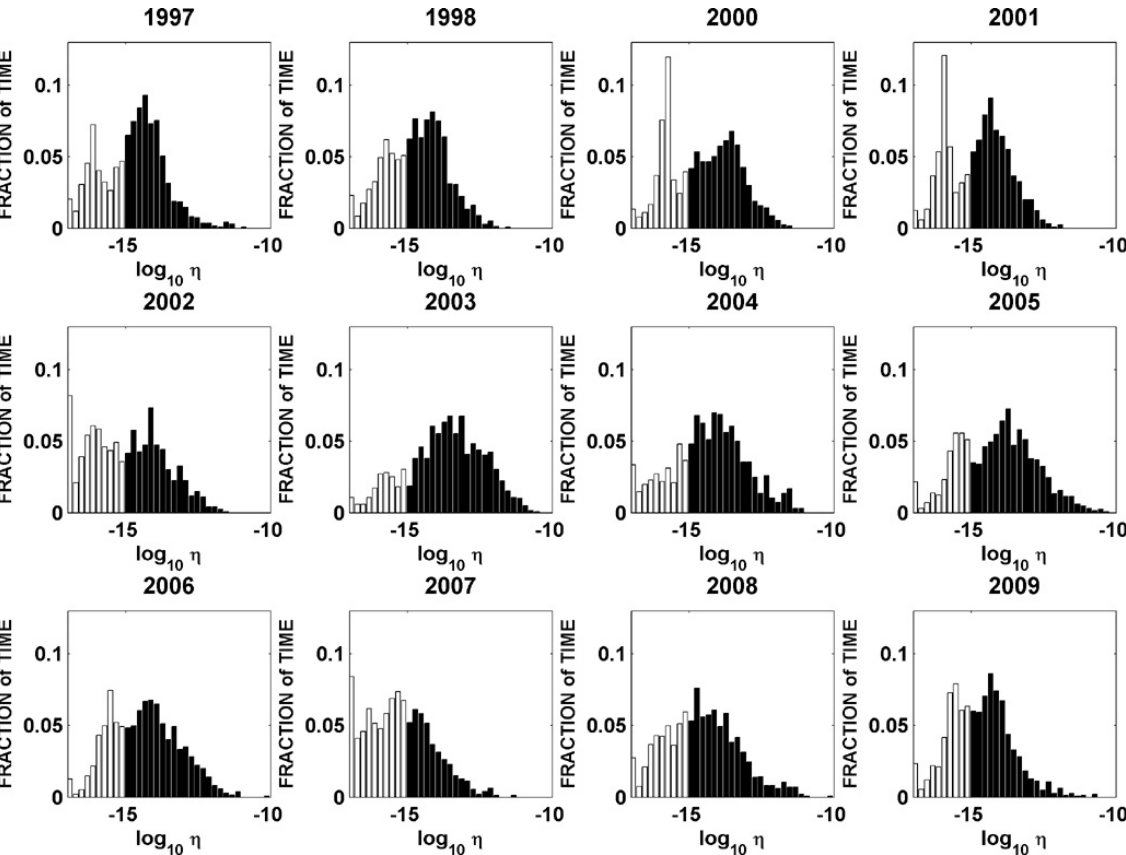
Fig. 3. The distributions of logarithm of ESRAD volume reflectivity for different years. The histograms refer to maximum η over altitudes 80–90km for one hour averages. White and black bars correspond to noise and PMSE, respectively.